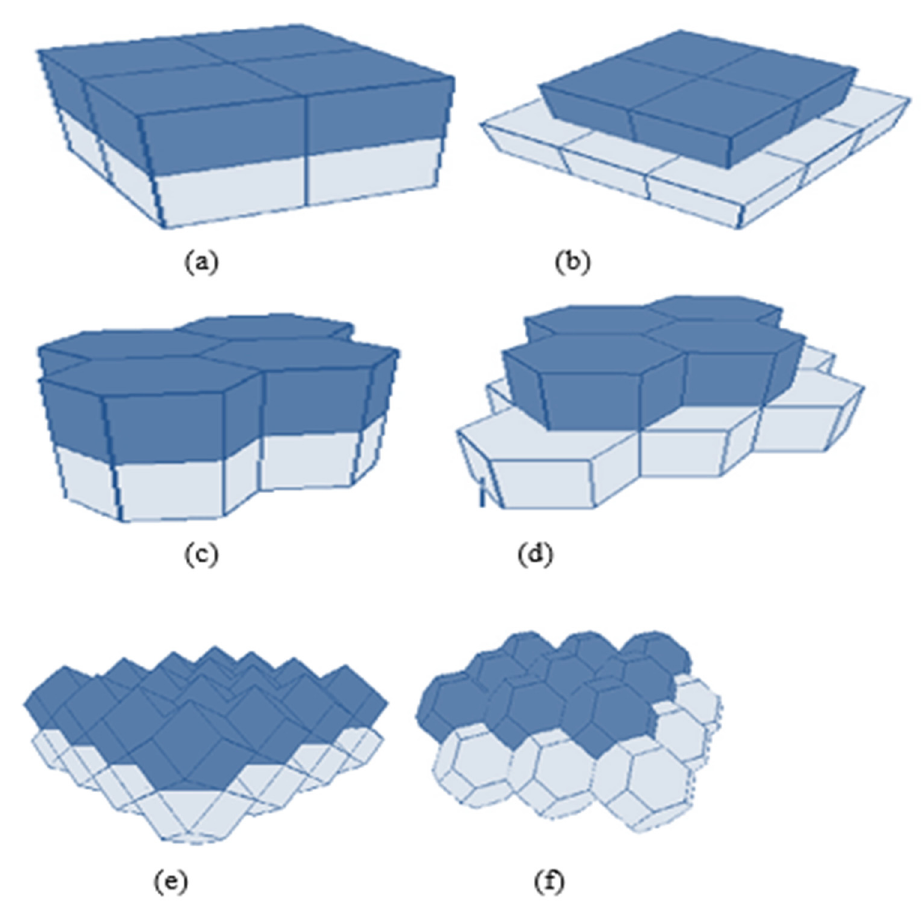
Figure 17. Different 3D space-partitioning shapes ( a ) a Cube, ( b ) an Alternative-cube, ( c ) a Hexagonal Prism, ( d ) an Alternative- hexagonal prism, ( e ) a Rhombic Dodecahedron, and ( f ) a Truncated Octahedron.